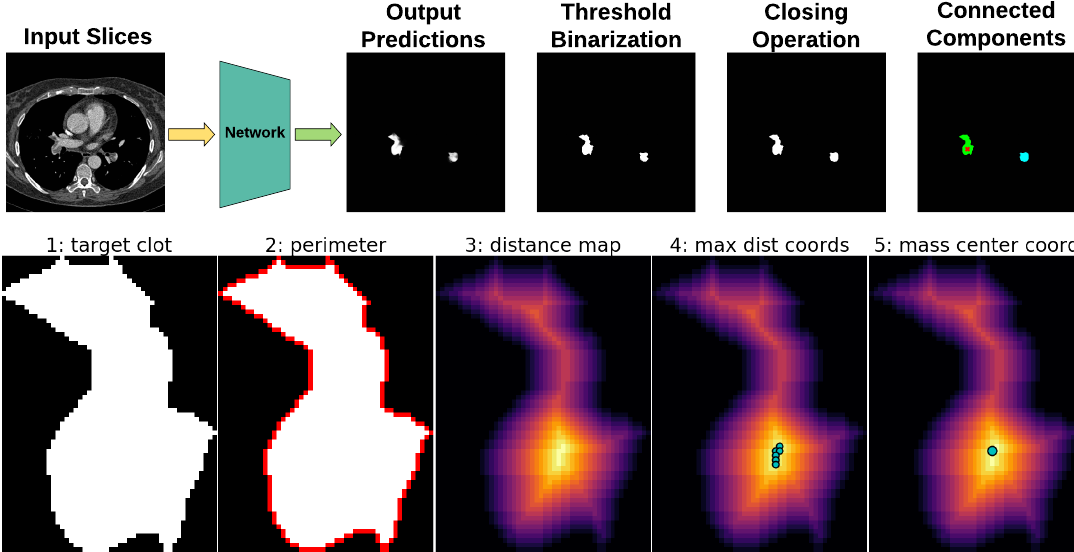
Figure 2. Post-processing pipeline illustration: ( top ) the operations performed on the segmentation network output; and ( bottom ) the method to extract coordinates from emboli segmentations. It should be noted that the process is done in three Dimensions . The coordinate associated with the blue embolus is in another axial